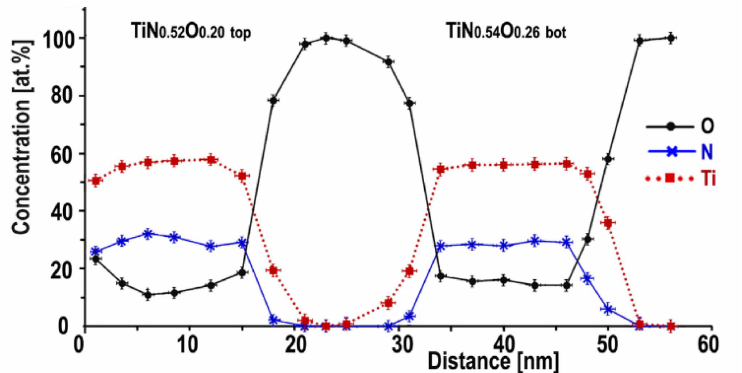
Figure 5. Concentrations in atomic % of N, Ti and O extracted from the line scan across the multilay- ered structure starting from the edge of TiN x O y top. The tiny crosses are error